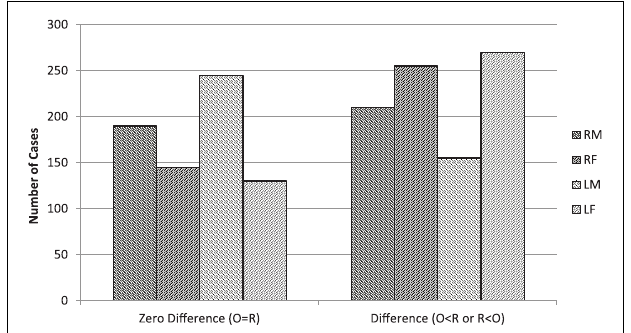
FIGURE 7 | Number of cases for all observers in which there was either a zero difference in verbal rating or there was a difference of any magnitude (with the original score being either more or less than the mirror-reversed image) . (R = Right-cheeked, L = Left-cheeked, M = Males, F =